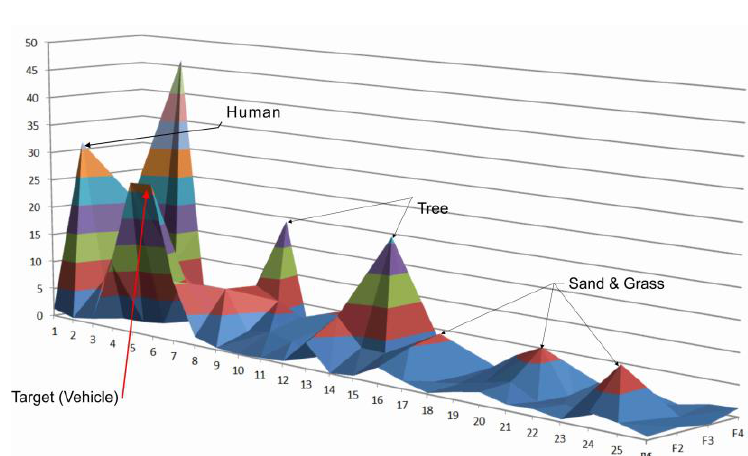
Fig. 5. Experiment. Conditions.